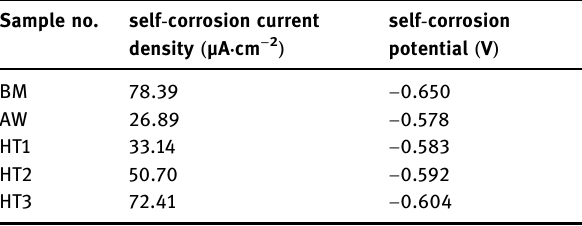
Table 4: Electrochemical corrosion parameters of samples in